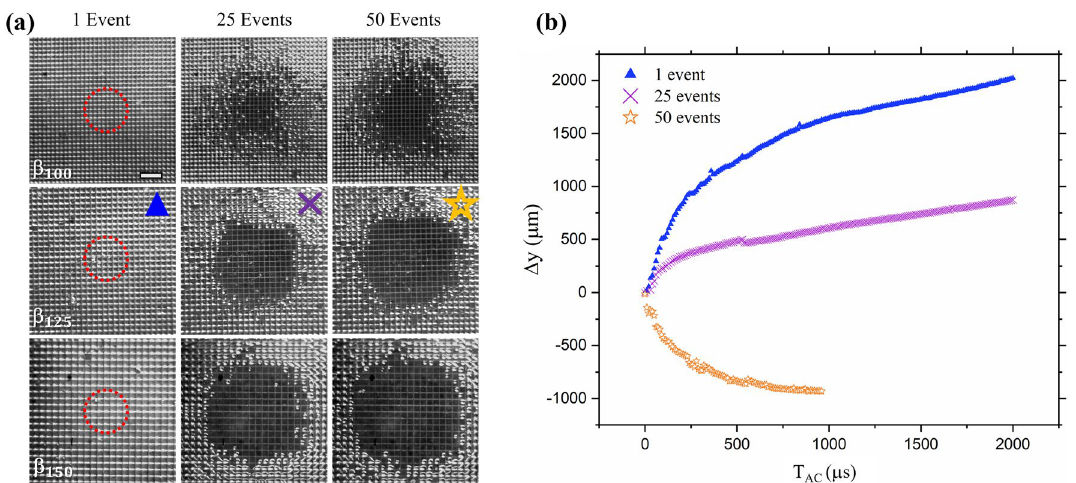
Figure 10. ( a ) Top view of microstructures showing wetting progression. Red dashed circle represents the projection of the maximum bubble size. Scale bar is 500 µm. ( b ) Displacement of cavitation bubble after 1, 25 and 50